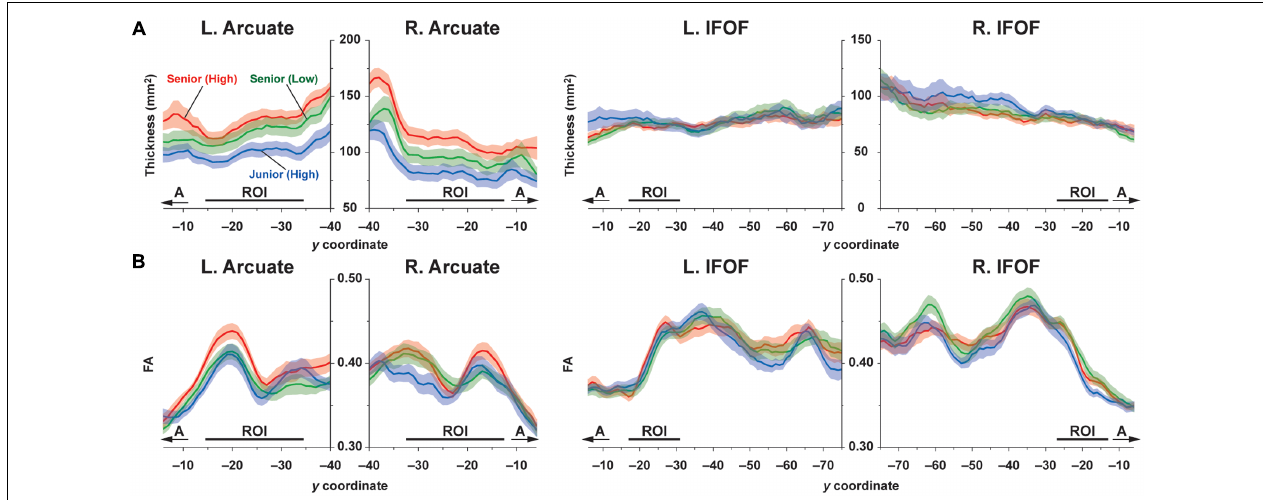
FIGURE 3 | Profiles of the thickness/FA of the dorsal and ventral pathways in each group. (A) The profiles of thickness for the Arcuate and IFOF. (B) The profiles of FA for the Arcuate and IFOF. The thickness and FA were averaged among the participants in each of the Junior (High), Senior (Low), and Senior (High) groups, as shown in blue, green, and red, respectively. Data are shown for the range of y = –40 ∼ –6 for the Arcuate and y = –75 ∼ –6 for the IFOF (bounded by the pairs of black lines in Figure 2 ) in the MNI space. Note that the thickness of the Arcuate in the Senior (High) group is larger than that in the Junior (High) group in both hemispheres. Moreover, FA in the left Arcuate in the Senior (High) group is higher than those in the other two groups. No clear group difference was found for the IFOF in either hemisphere. The SEMs in each group are shown as shaded bands in each color. The positions of ROIs are indicated by the black lines above the axes. A, anterior.